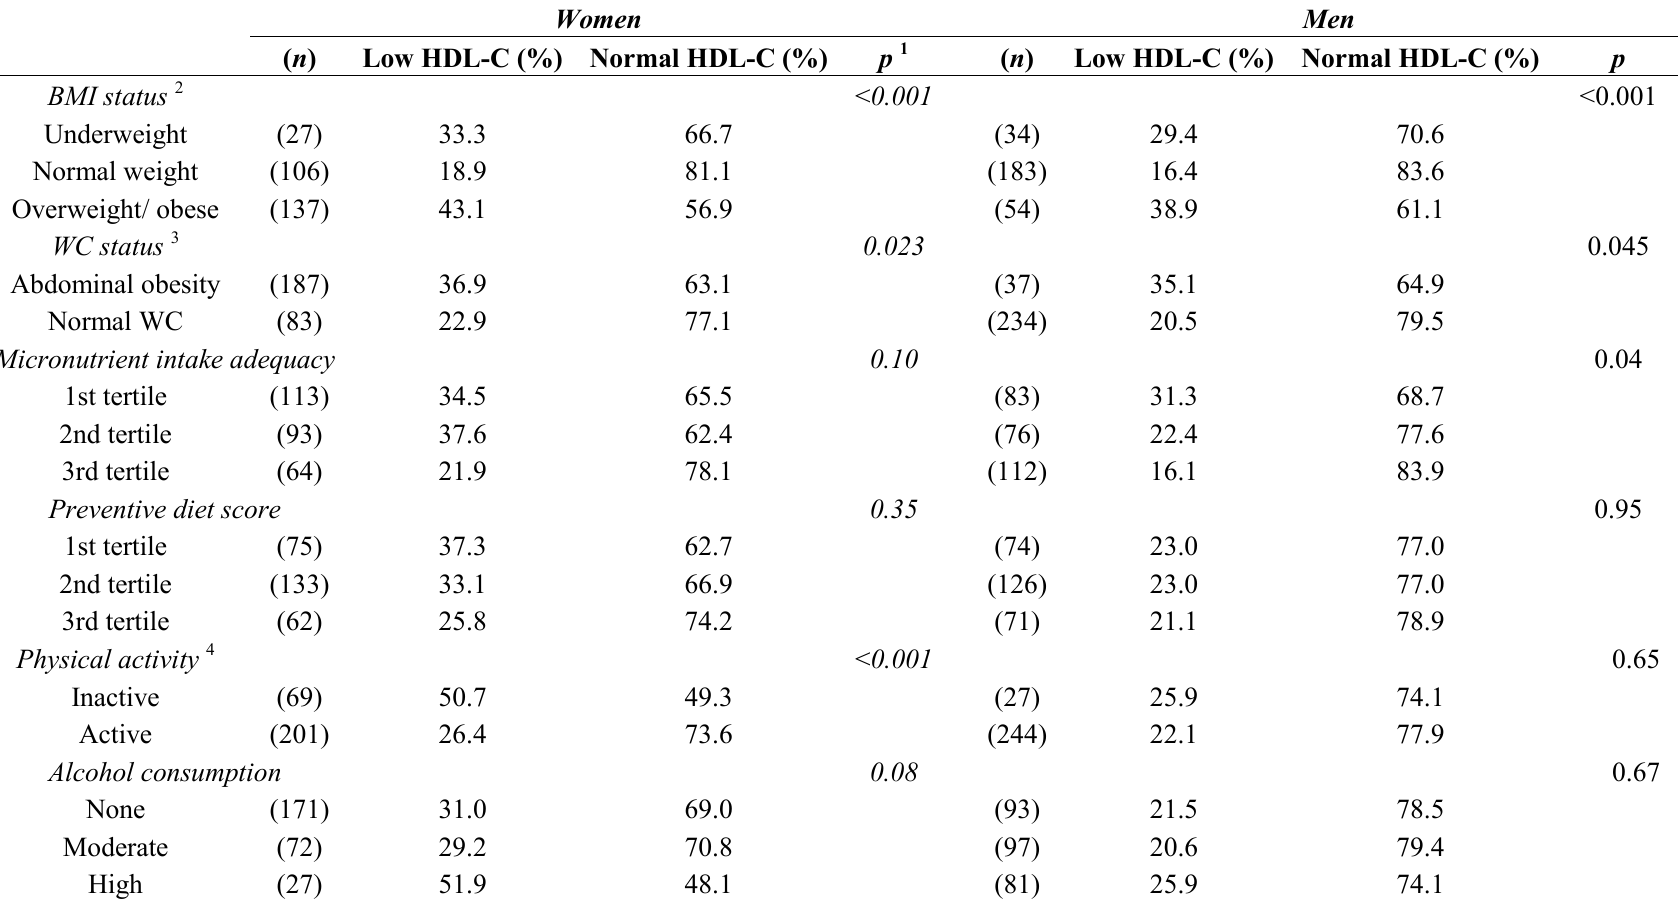
Table 3. Nutritional status, diet quality and lifestyle according to HDL-C